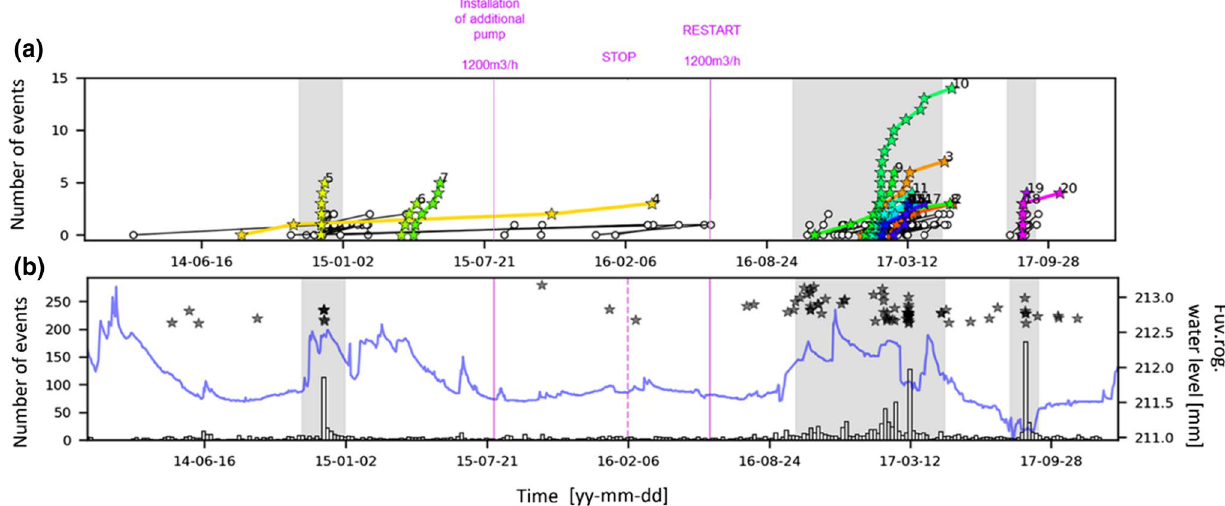
Fig. 7 Temporal distribution of seismic activity a Events of each family and b Compared with water levels measured at Fuveau Rognacien well (around 2 km distance), corresponding to the rainfall data. Pumping capacity changes are marked with pink